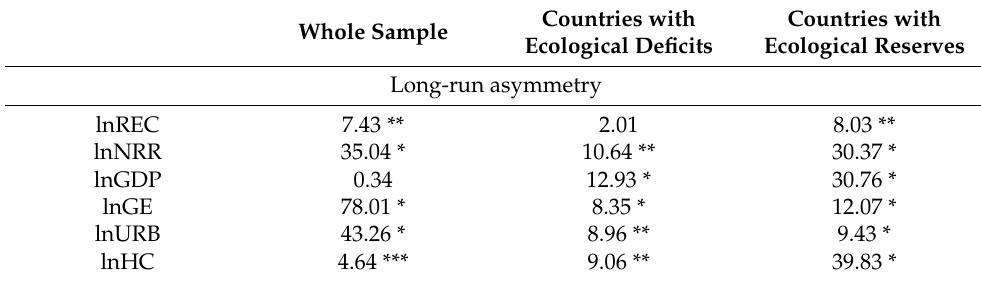
Table 9. Results of Wald tests.